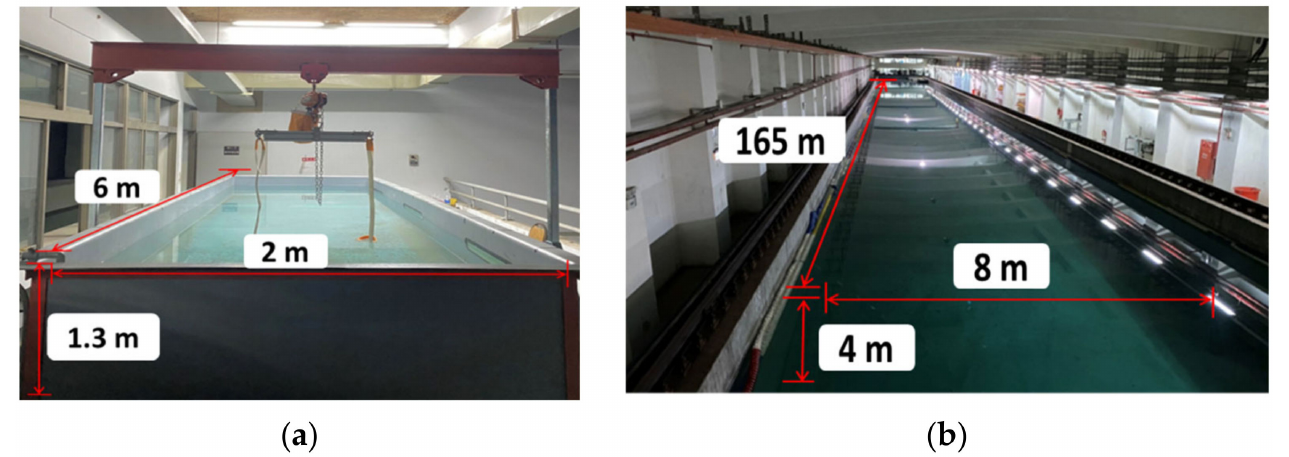
Figure 12. The exterior and the dimension of ( a ) the stability water tank, and ( b ) the towing tank.